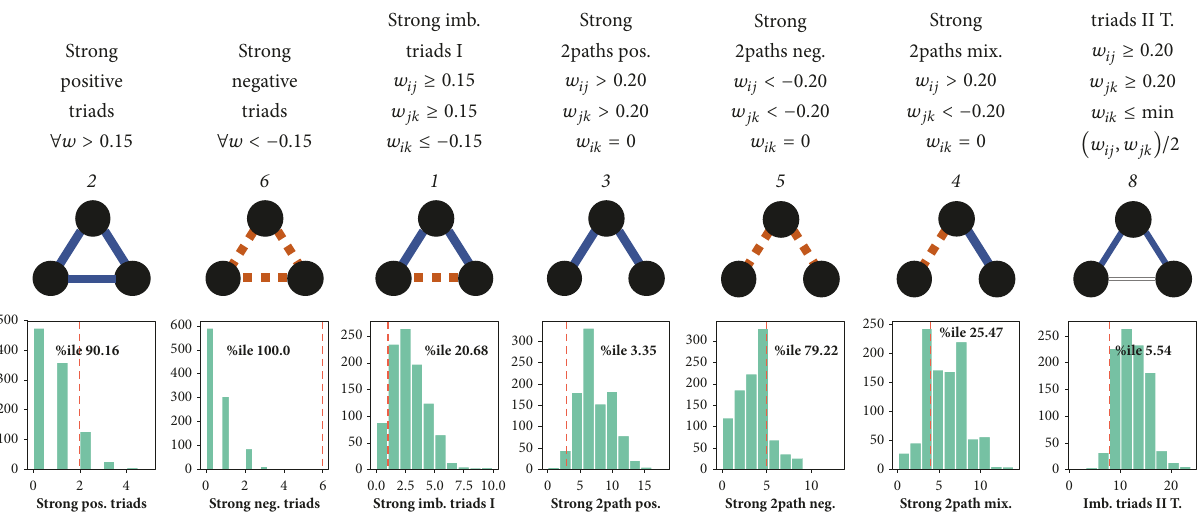
Figure 11: Weighted and signed motifs, name used in this study, the definition, schematic figure, and the figure showing distribution of motif frequencies in 1000 random networks with the same degree sequence and weight distribution and percentile value of the frequency of empirical network in that